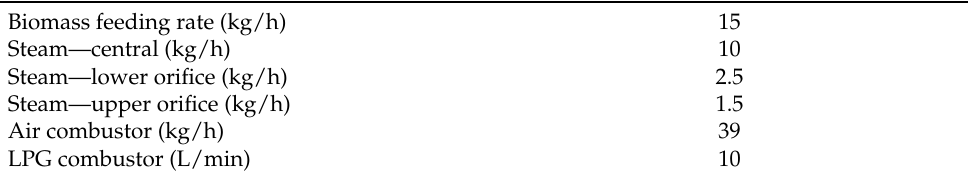
Table 3. Input conditions for gasification